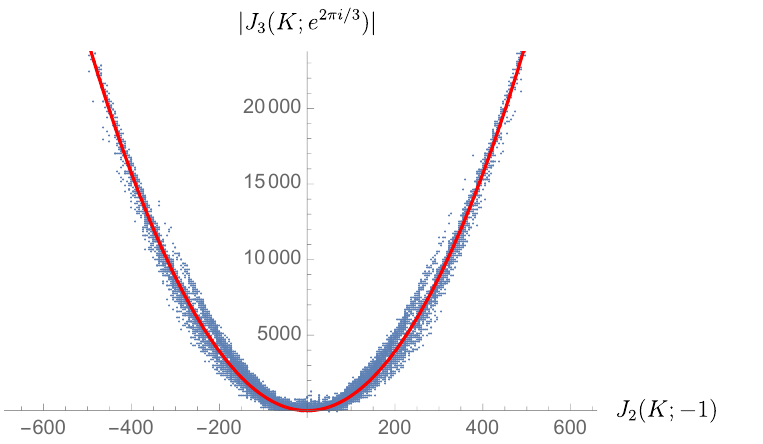
Figure 1 . The n = 2 and n = 3 colored Jones polynomials evaluated at roots of unity show a quadratic